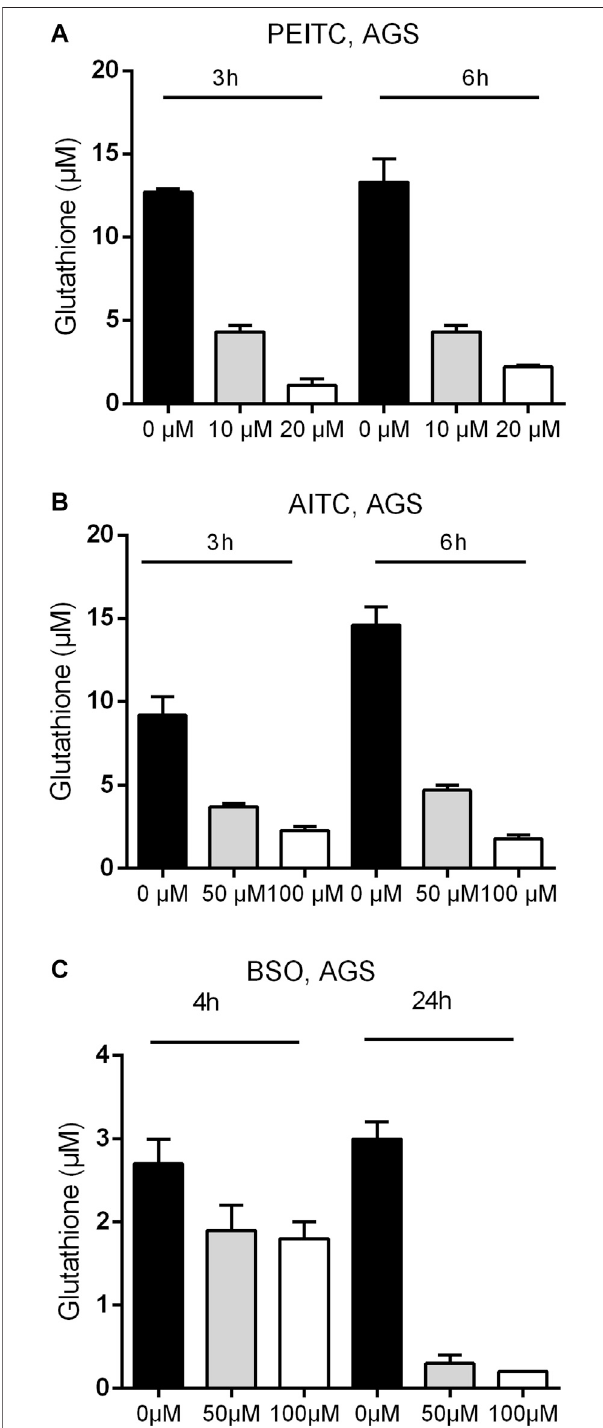
FIGURE 3 | Glutathione concentration upon 3 and 6 h treatments with PEITC (A) or AITC (B) on AGS cells and upon 4 and 24 h of treatment with BSO (C) on AGS cells. Mean + SD of n (cid:1) 4 replicates/treatment. PEITC, phenethyl isothiocyanate; AITC, allyl isothiocyanate; BSO, Buthionine sulfoximine.